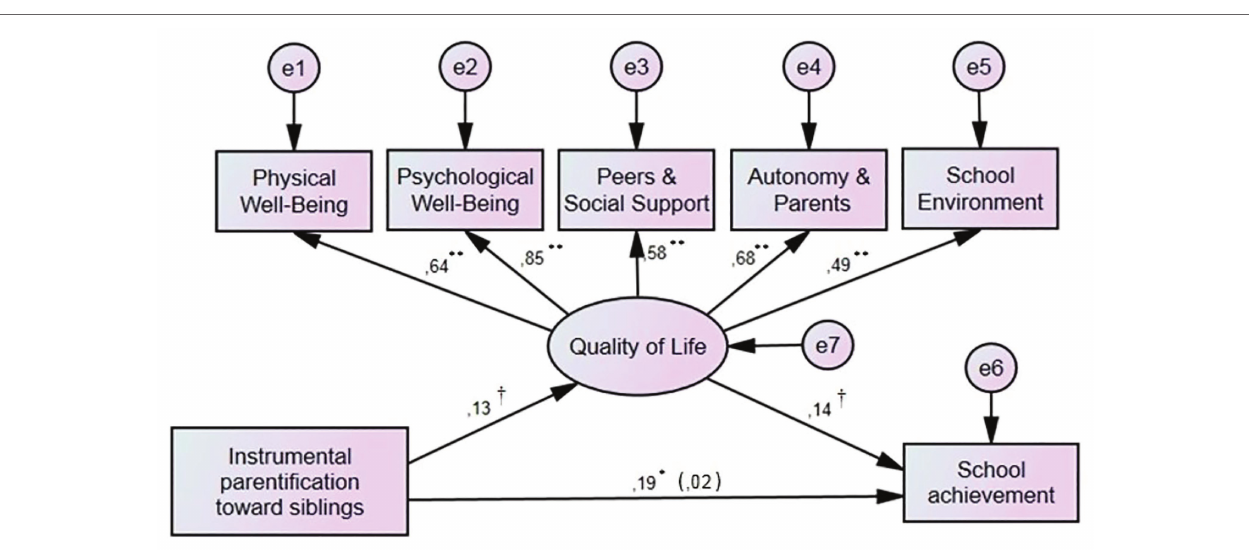
FIGURE 2 | The mediating effect of quality of life on the relation between instrumental parentification toward siblings and school achievement. * p < 0.05; ** p < 0.01; † p < 0.1.